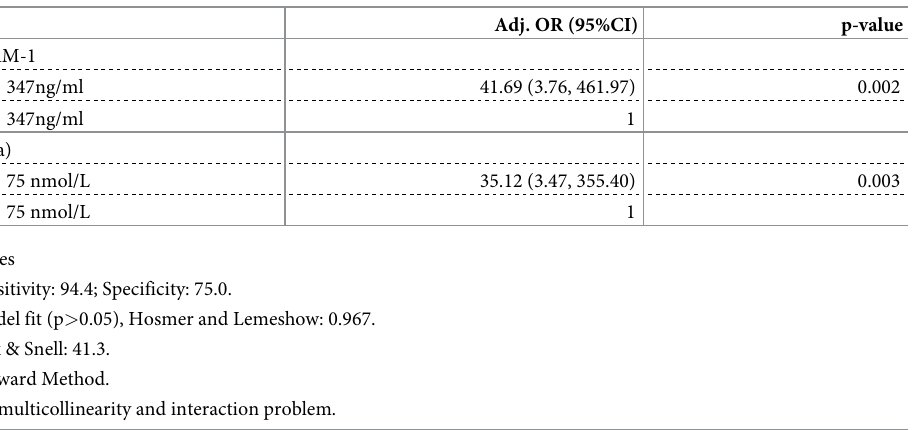
PLOS ONE | https://doi.org/10.1371/journal.pone.0253298 June 30,